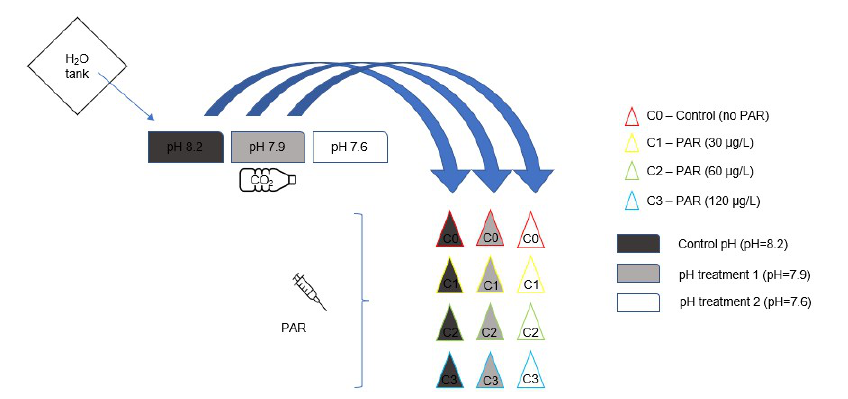
Scheme 1. A schematic representation of the experimental set-up in which the 4 levels of organization are represented (i.e., first level sweater tank (1); second level CO 2 mixing flasks (3); third level, contaminant mixing flasks (4); fourth level, experimental units